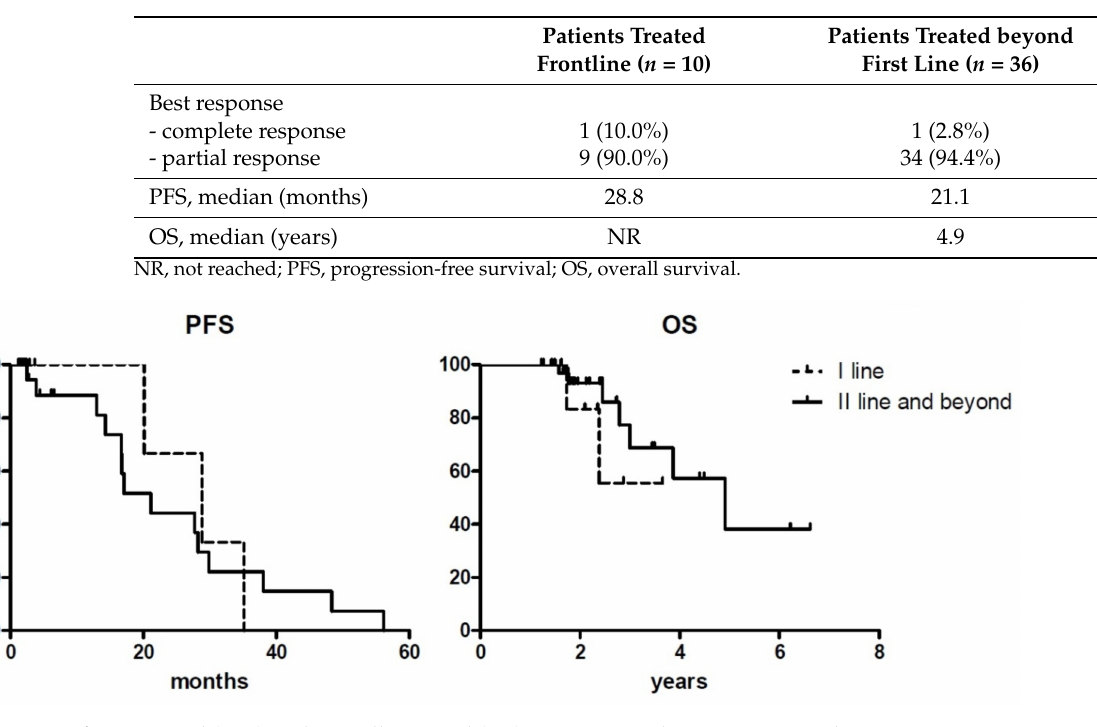
Table 2. Outcomes according to treatment line.